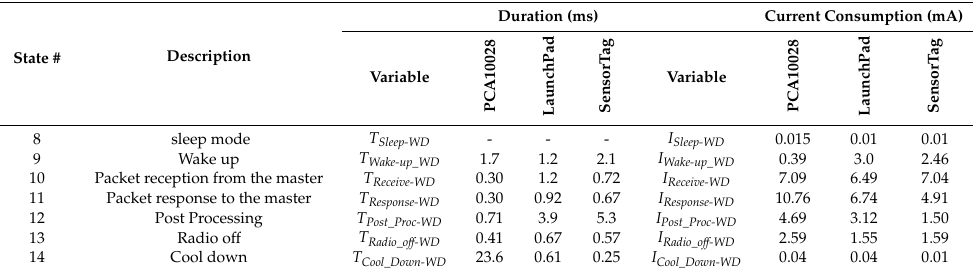
Table 2. State characterization of a connection interval with data packet transmission.